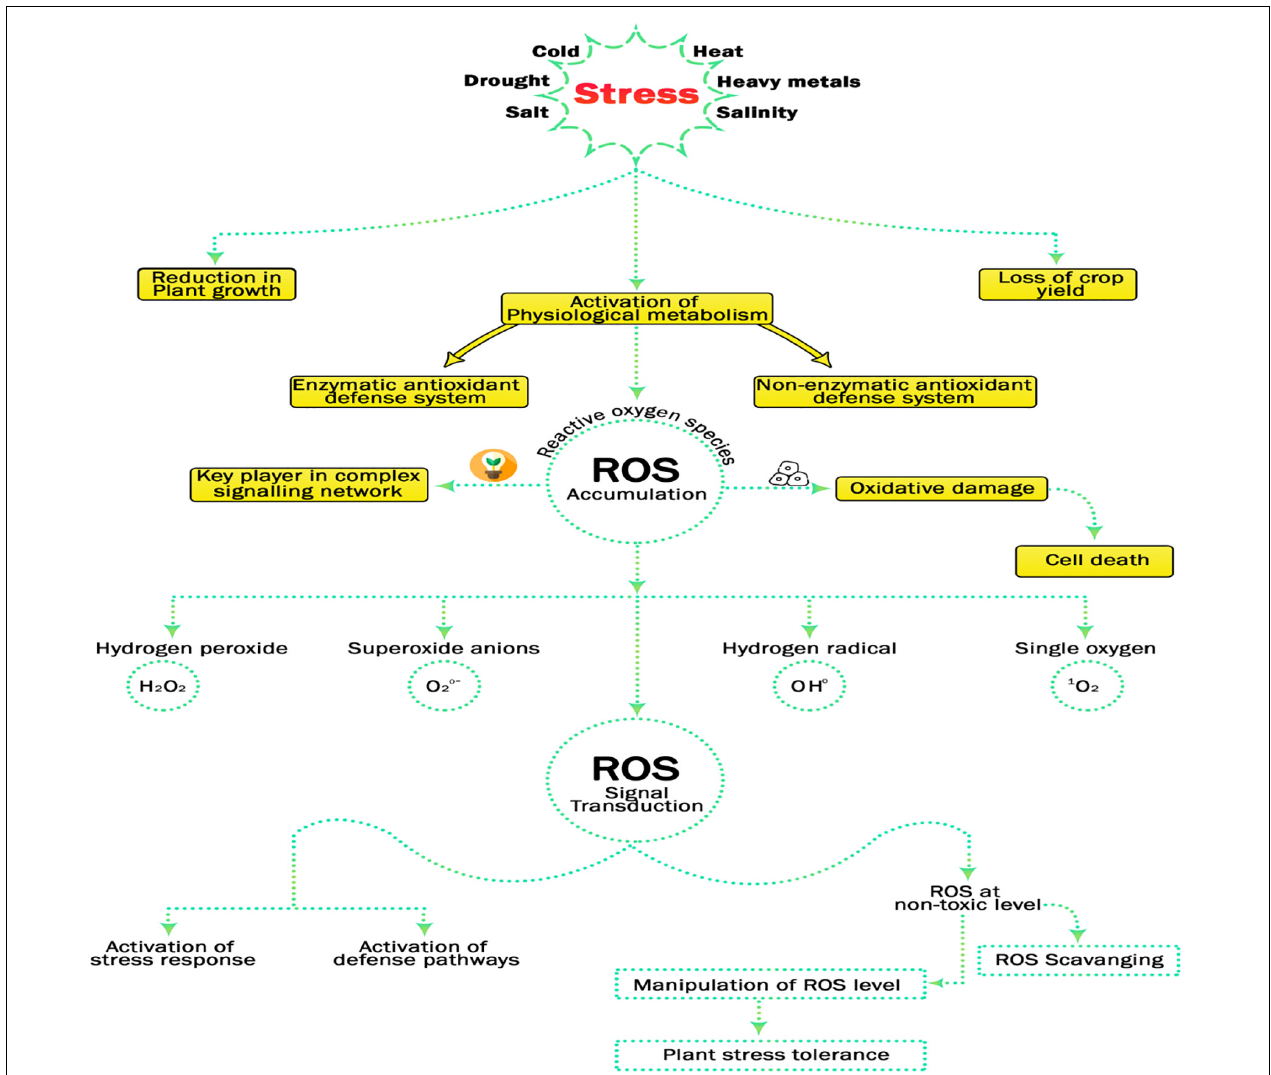
FIGURE 1 | Importance of Reactive oxygen species in signal transduction and activation of defense pathways if at non-toxic level and its manipulation confers plant stress